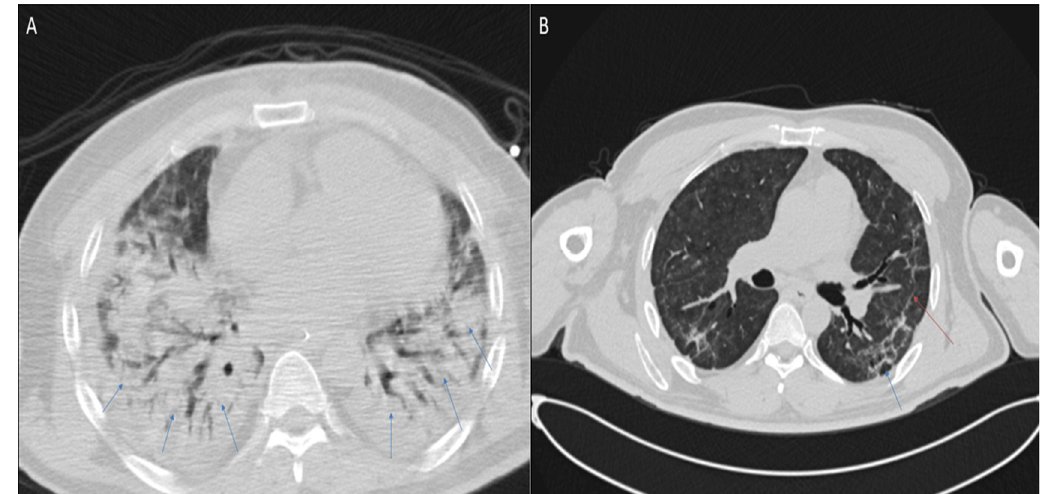
Figure 6. Axial chest CT images (lung window) of a 47-year-old patient obtained ( A ) at hospital admission with confirmed acute COVID-19 shows signs of bilateral polysegmental pneumonia and ground-glass opacities. Lung damage ~80%. Blue arrows indicate infiltration of the lung parenchyma; ( B ) six months after acute COVID-19 shows traction wall thickening of segmental and subsegmental bronchi in the parenchyma of both lungs. Fibrous cords, irregularly linear forms, without signs of infiltration, mediastinal lymphadenopathy. Fibrosis is marked with a red arrow, dilated bronchus with a blue arrow.